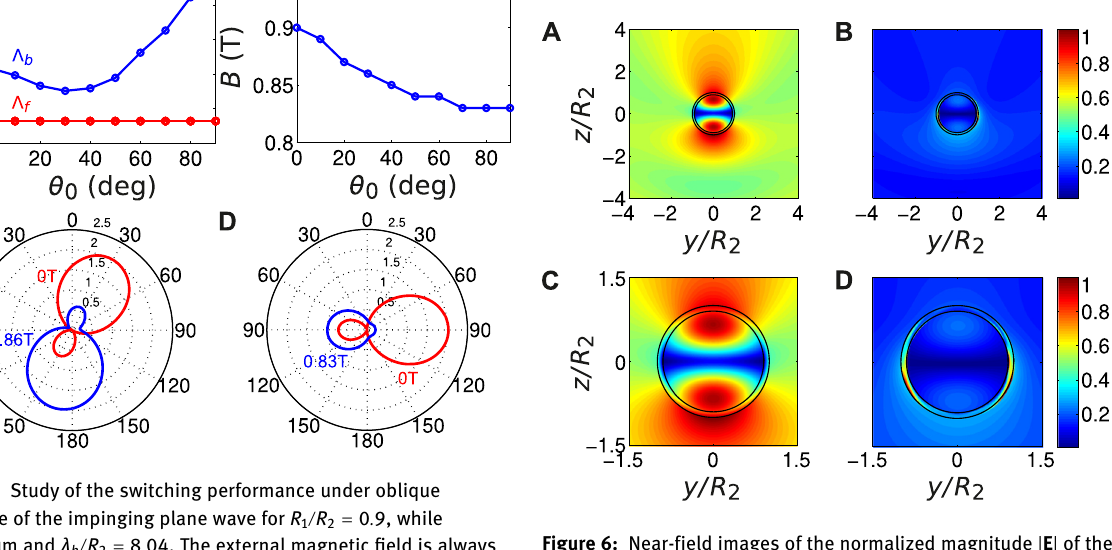
Figure 6: Near-field images of the normalized magnitude | E | of the total electric fi eld on yz -plane. The values of parameters are the same with the ones in Figure 3C and the antenna is stimulated at λ / R (cid:2) 8 . 04. (A) Forward-scattering operation at 0 T. (B) 2 b Back-scattering operation at 0.9 T. (C) Zoom-in plot at 0 T. (D) Zoom-in plot at 0.9